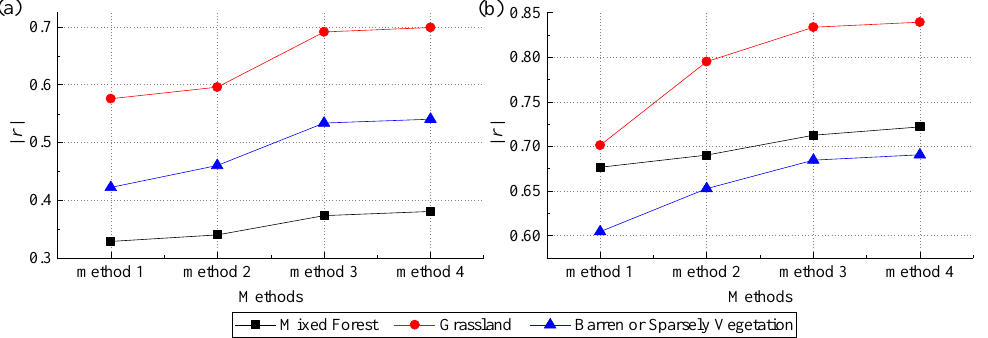
Figure 9. The average | r | of NDVI of each vegetation community with precipitation and temperature formulated by each method. ( a ) Precipitation; ( b ) temperature.